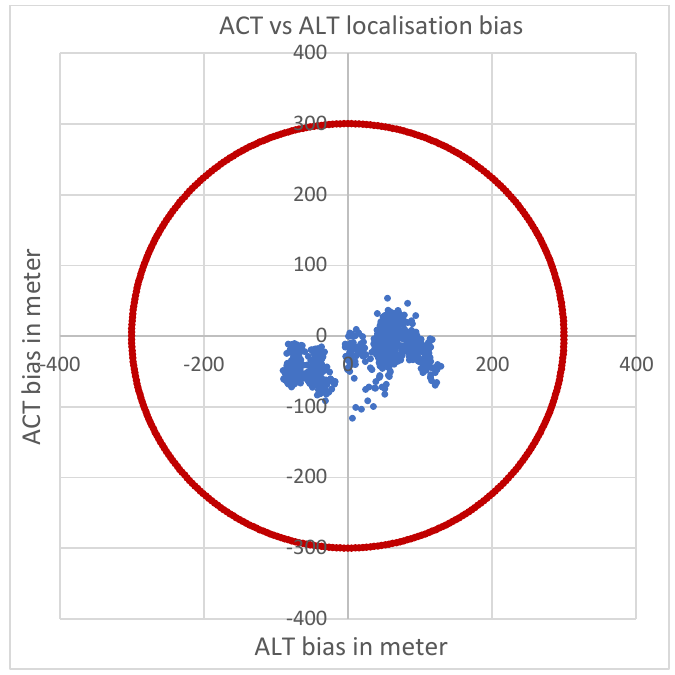
Figure 21. Across-track versus along-track localization performances assessed between January 2019 and May 2020 (blue) compared to 300 m requirement (red).